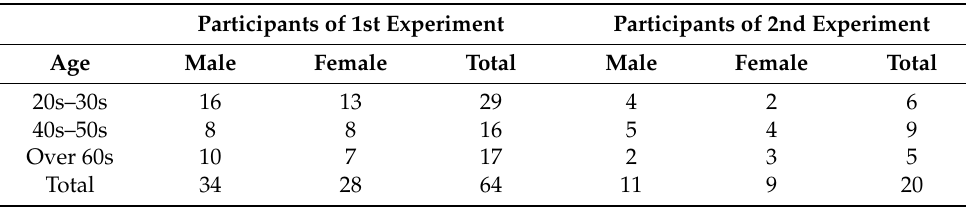
Table 1. Age and Gender of